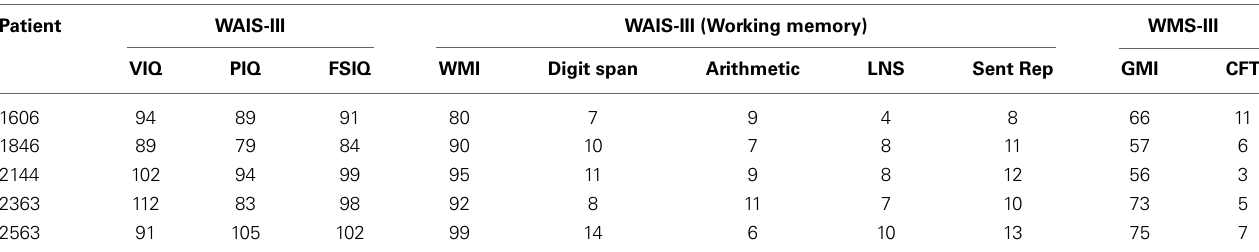
Table 2 | Neuropsychological test